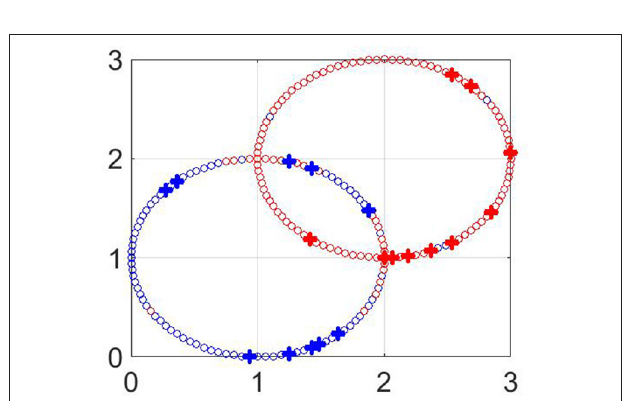
FIGURE 5 | Classification of “two non-intersecting circles” dataset. The values of parameters are n = 200, m = 2, M = 70, p = 0.5, q = 0.9.